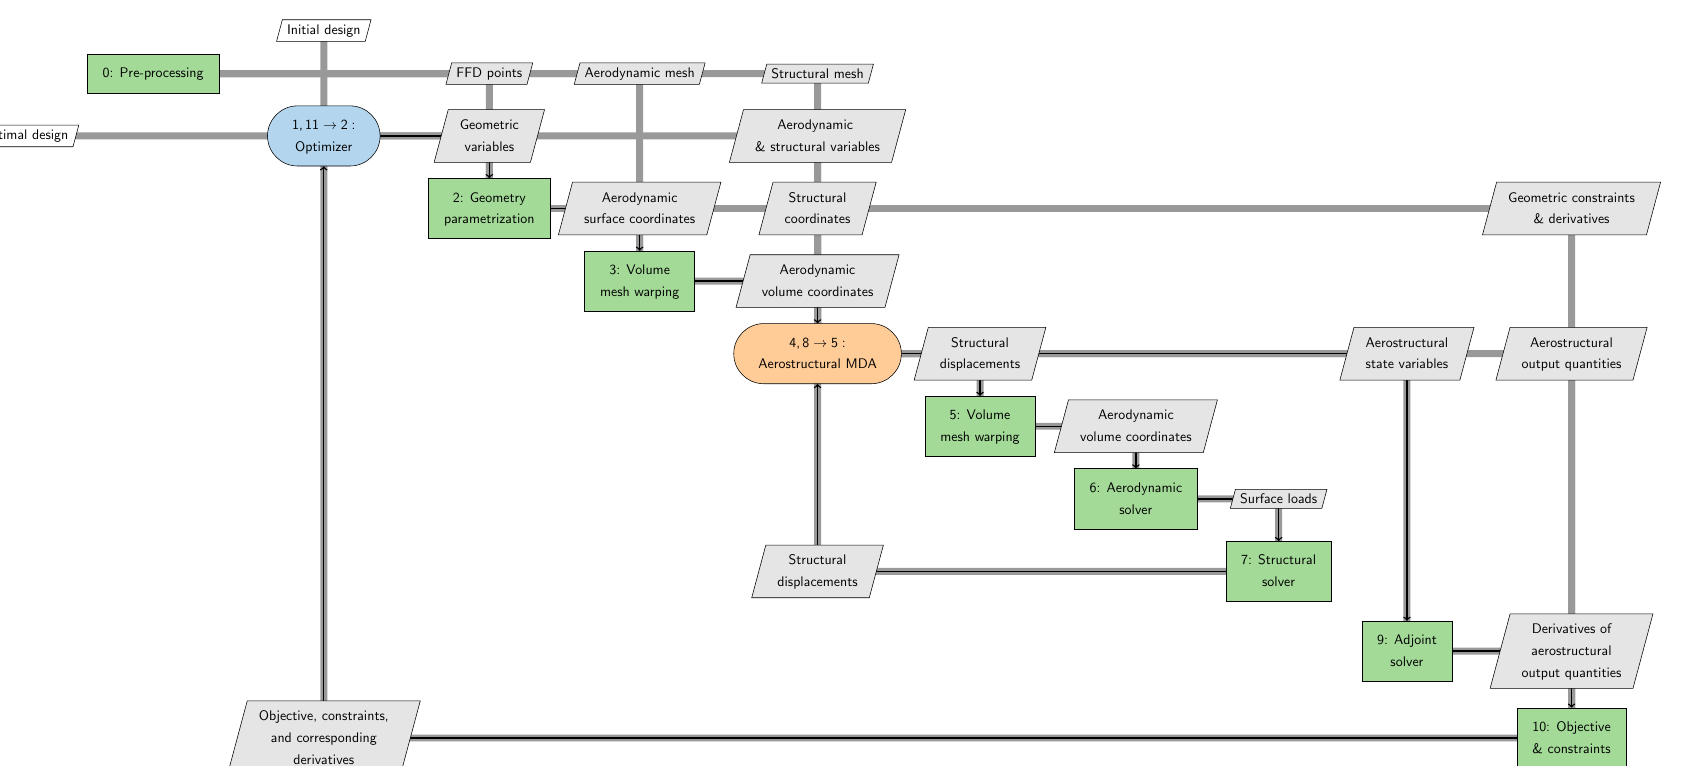
Figure 2. XDSM diagram of aerostructural optimization with